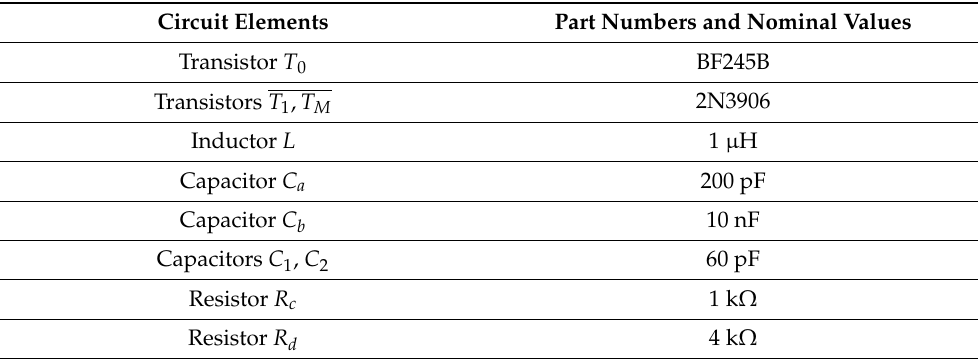
Table 15. Circuit elements used in the oscillator with MIWCM assembled on a solderless